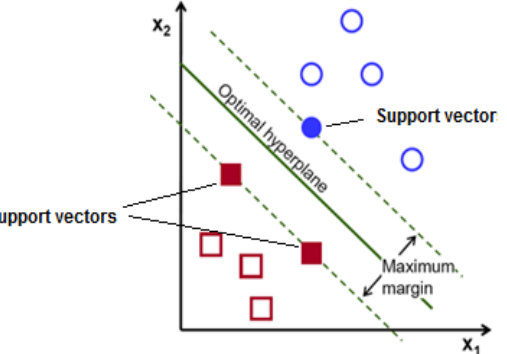
Figure 4. An example of a separable problem in a 2-dimensional space.